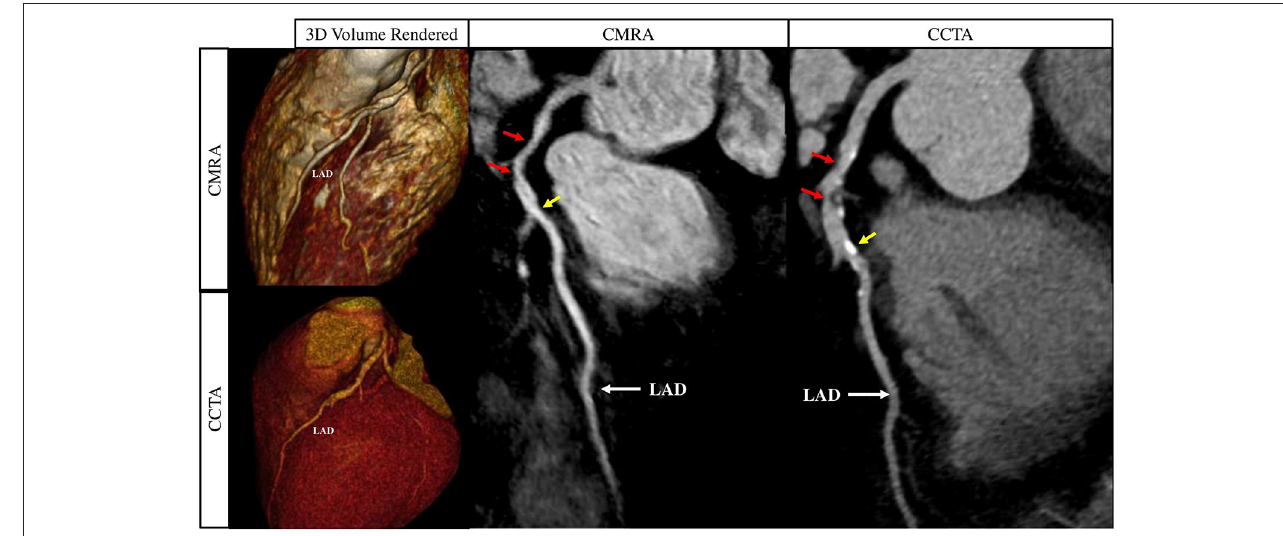
FIGURE 10 | Curved multiplanar reformat and 3D volume rendered non-contrast CMRA and contrast enhanced CCTA in a 60 year old male with > 50% partially calcified stenosis in the proximal to mid LAD on either side of the first diagonal artery (red arrows). The yellow arrows represent a focal calcified < 50% stenosis just distal to the second diagonal artery. CMRA, Coronary Magnetic Resonance Angiography; CCTA, Coronary Computed Tomography Angiography; LAD, Left Anterior Descending Artery. Adapted with permission from Hajhosseiny et al. (66).